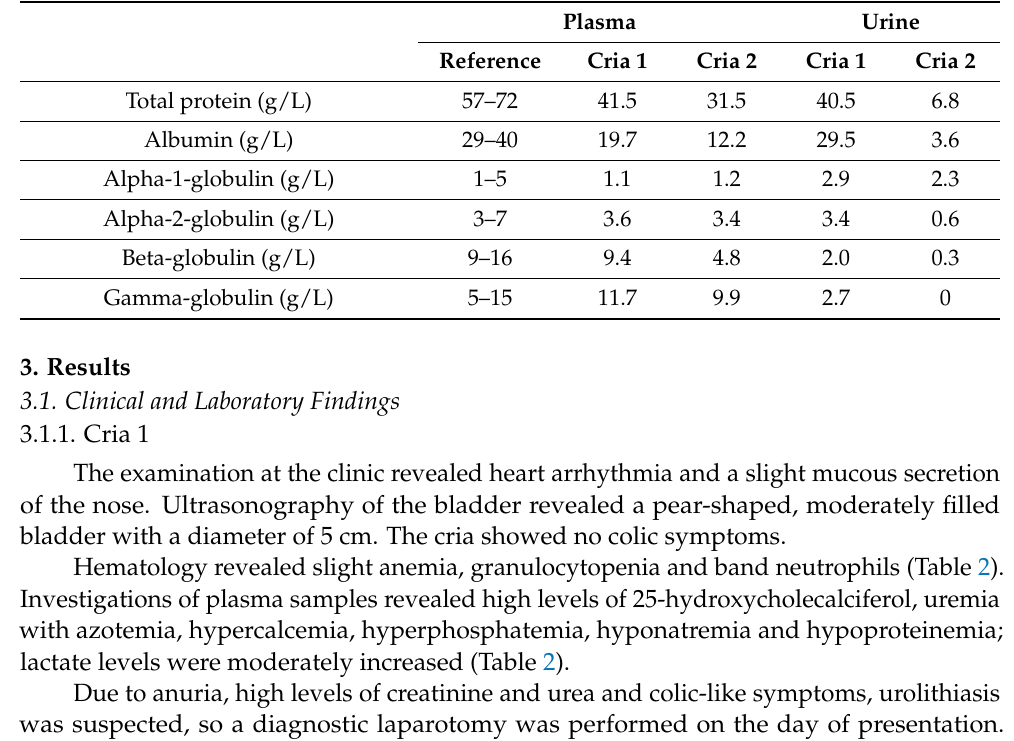
Table 6. Electrophoresis of serum and urine proteins. Reference values for serum proteins in accordance with Dawson et al. [33]. For urine proteins, no reference values for SACs were